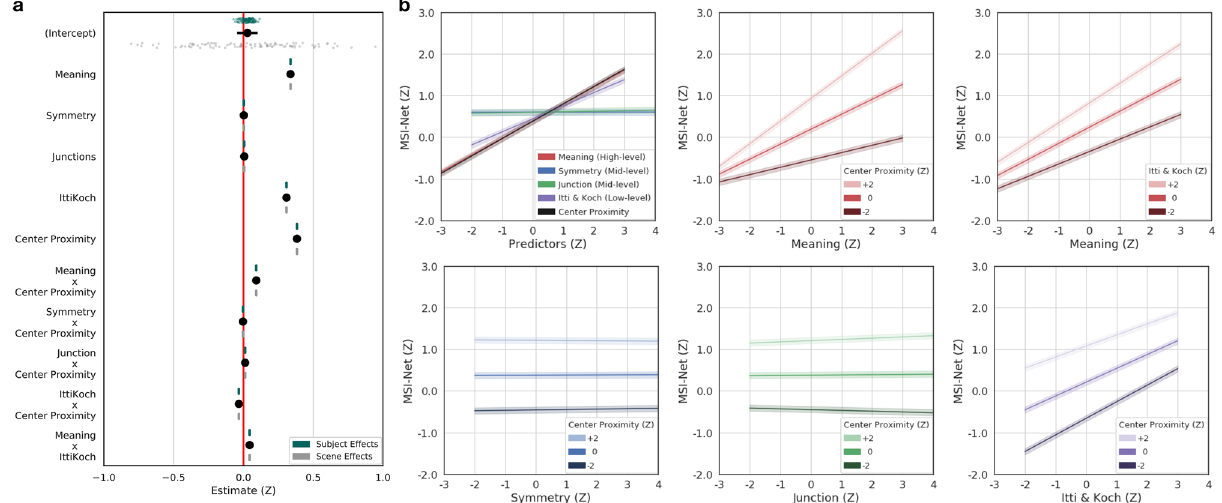
Figure 3. MSI-Net linear mixed effects model, marginal effects, and interactions. ( a ) Fixated MSI-Net values as a function of low-, mid-, and high-level features and interactions. The black dots with lines show the fixed effect estimates and their 95% confidence intervals. Subject (green dots) and scene (grey dots) were both accounted for in the model as random intercepts. ( b ) Line plots of all model marginal effects and all model interactions. All error bands reflect 95% confidence intervals.